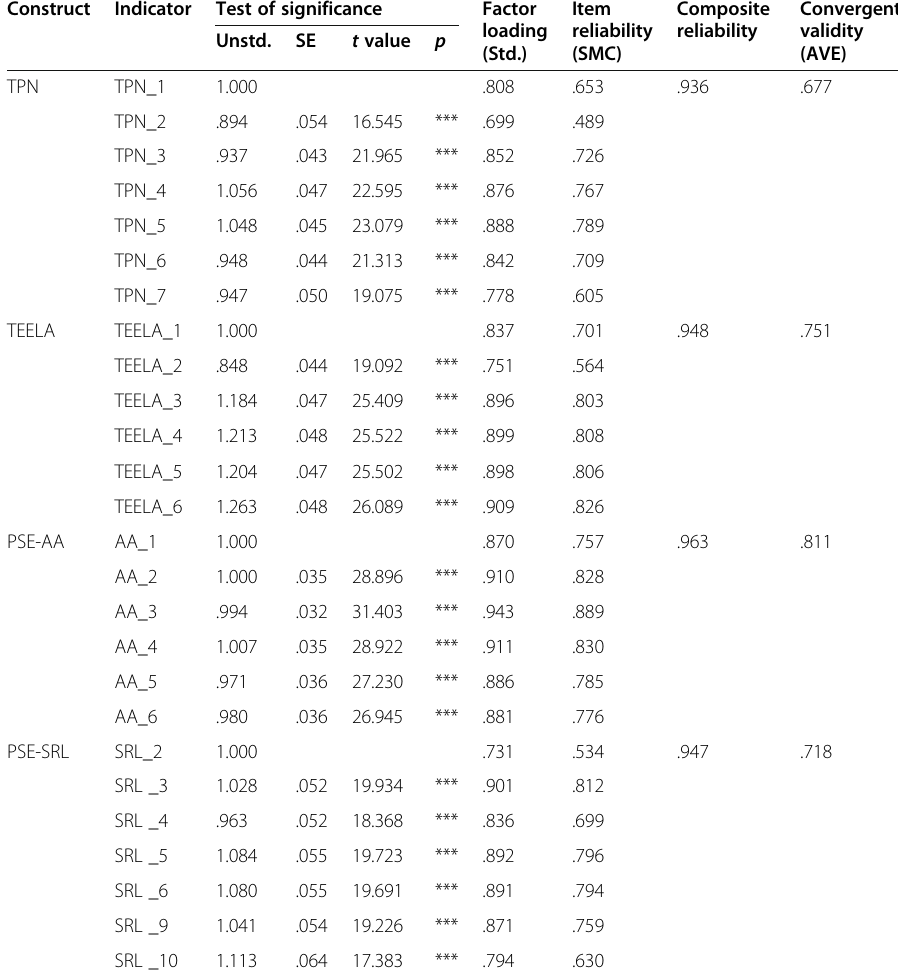
Table 4 The results of construct validity Construct Indicator Test of significance